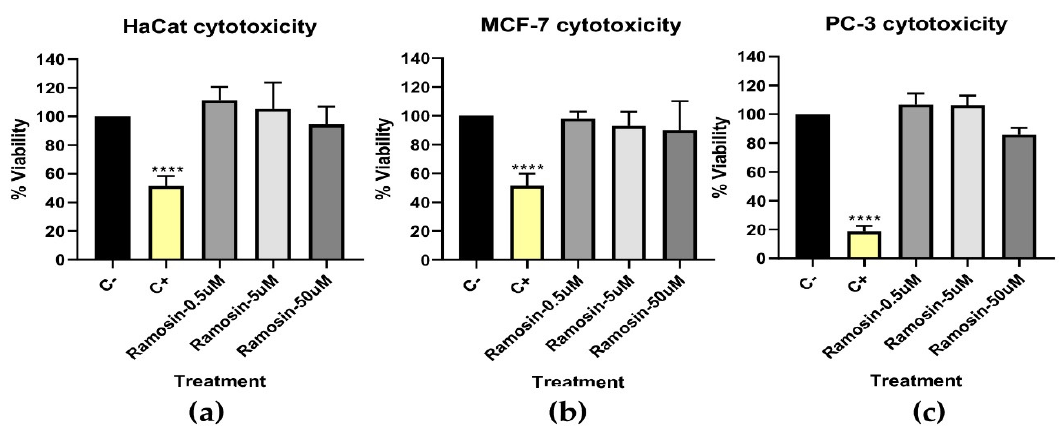
Figure 7. Screening test to determine the percentage of viability by the reduction of MTT in the cell lines ( a ) HaCat, ( b ) MCF-7, and ( c ) PC-3 treated with the Ramosin peptide at concentrations of 0.5 µ M, 5 µ M, and 50 µ M for 24 h. C − : untreated cells. C+: cells treated with H 2 O 2 . Three independent experiments were carried out. Data are presented as mean ± SD. ****: p < 0.001.